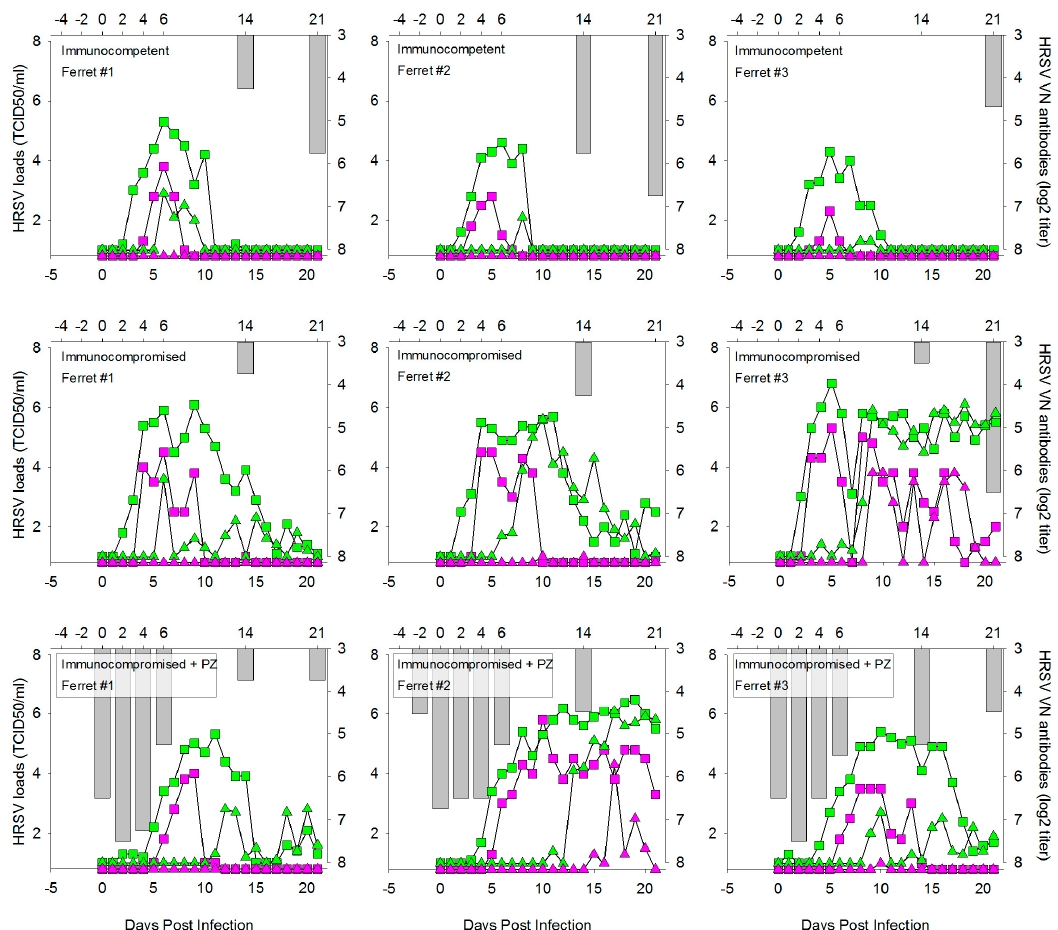
Figure 4. HRSV loads and virus neutralizing (VN) serum antibody responses in individual ferrets at different time points after IT infection with wild ‐ type HRSV subgroup A. HRSV loads ( left y ‐ axis and bottom x ‐ axis) detected by qPCR and virus isolation are shown as green and purple symbols, respectively. Virus loads in throat and nose swabs are shown by square and triangle symbols, respectively. VN serum antibody levels ( right y ‐ axis and top x ‐ axis) are shown as reciprocal